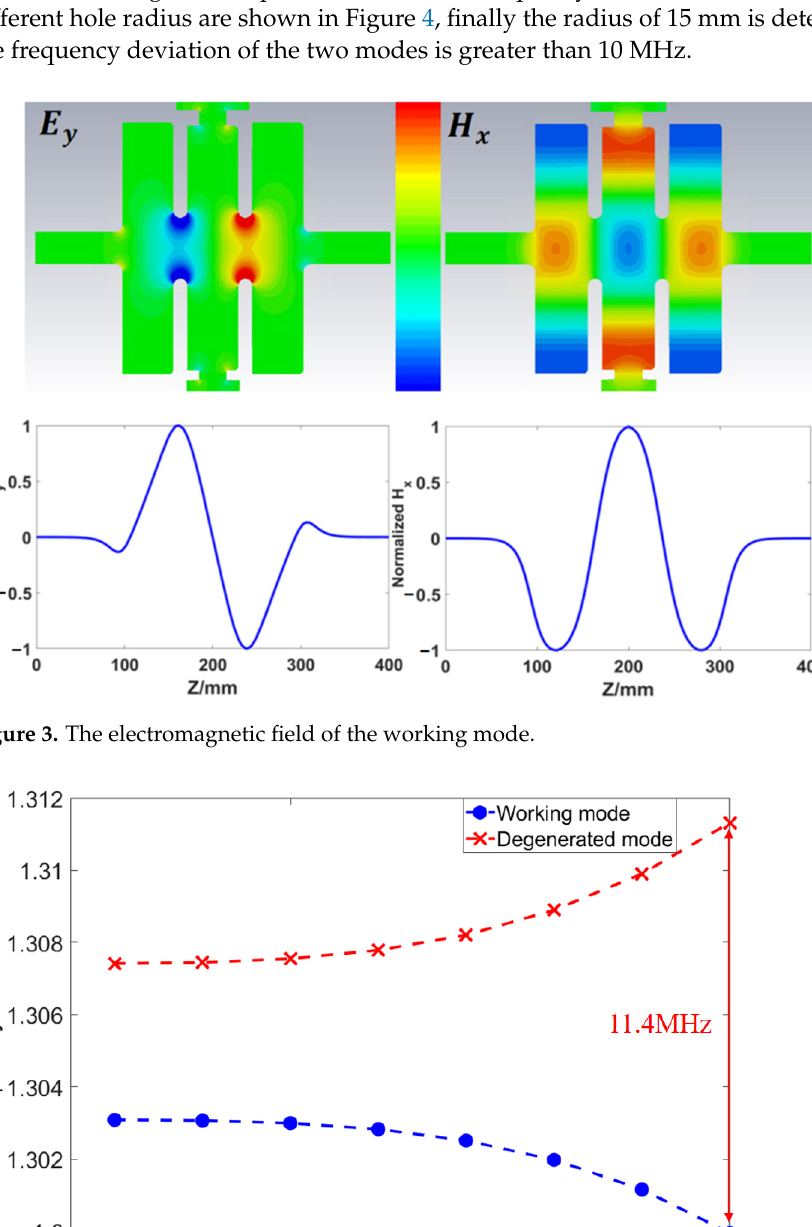
Table 2. Design parameters of the deflecting cavity.